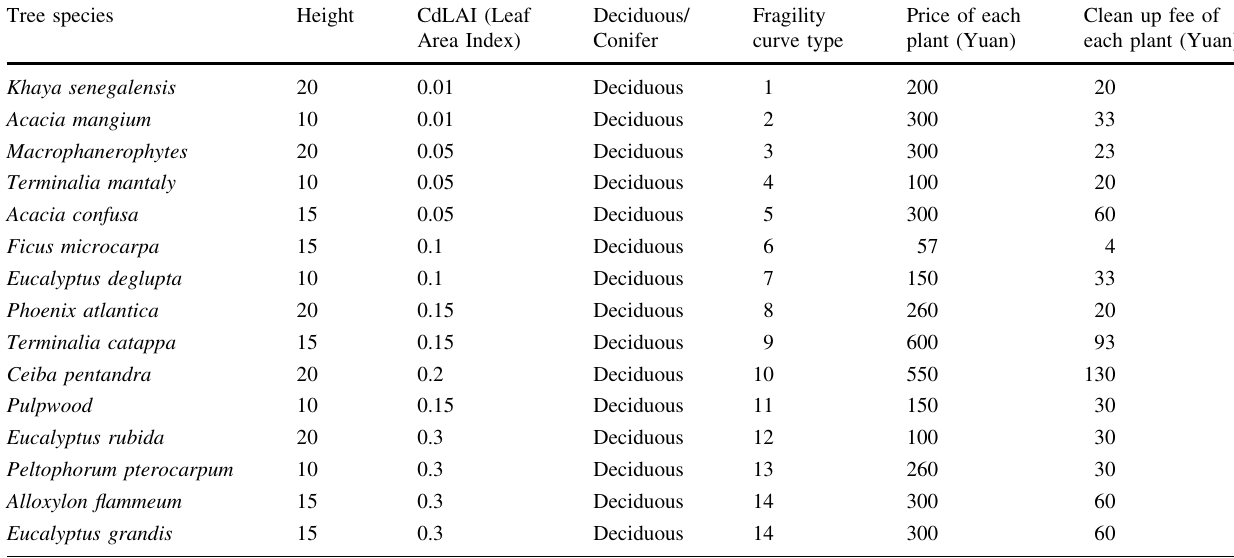
Beaufort wind levels from 10 to 17. RW radius of wind Table 2 Roadside tree species and their properties on Hainan Island Tree